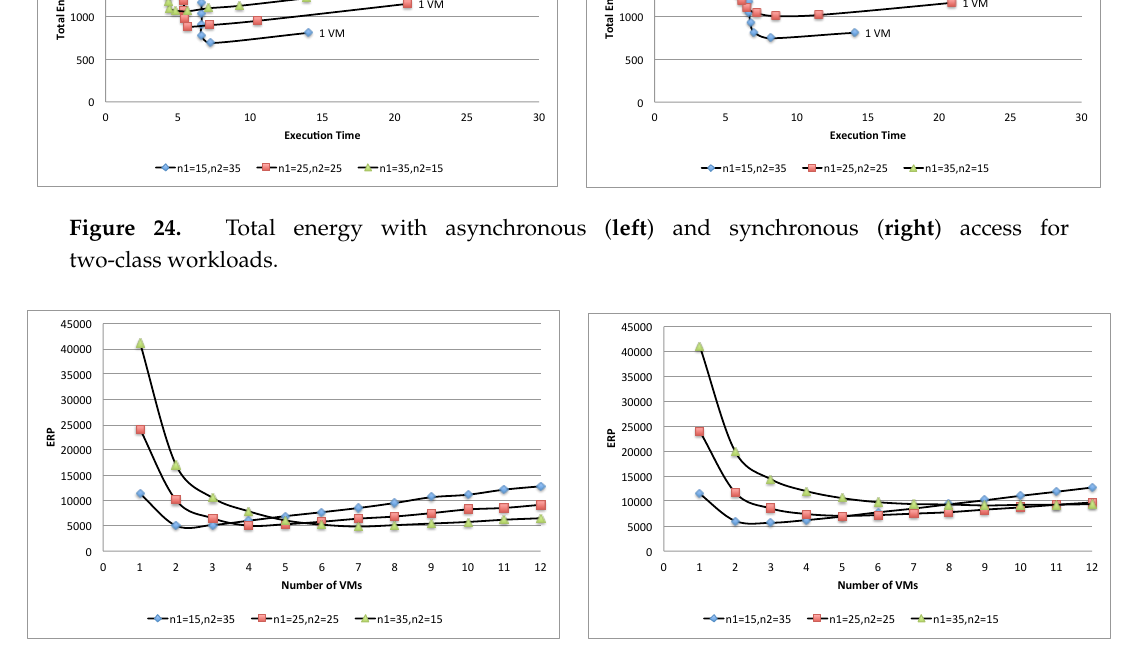
Figure 25. Trade-off between total energy and execution time with asynchronous ( left ) and synchronous ( right ) access for two-class